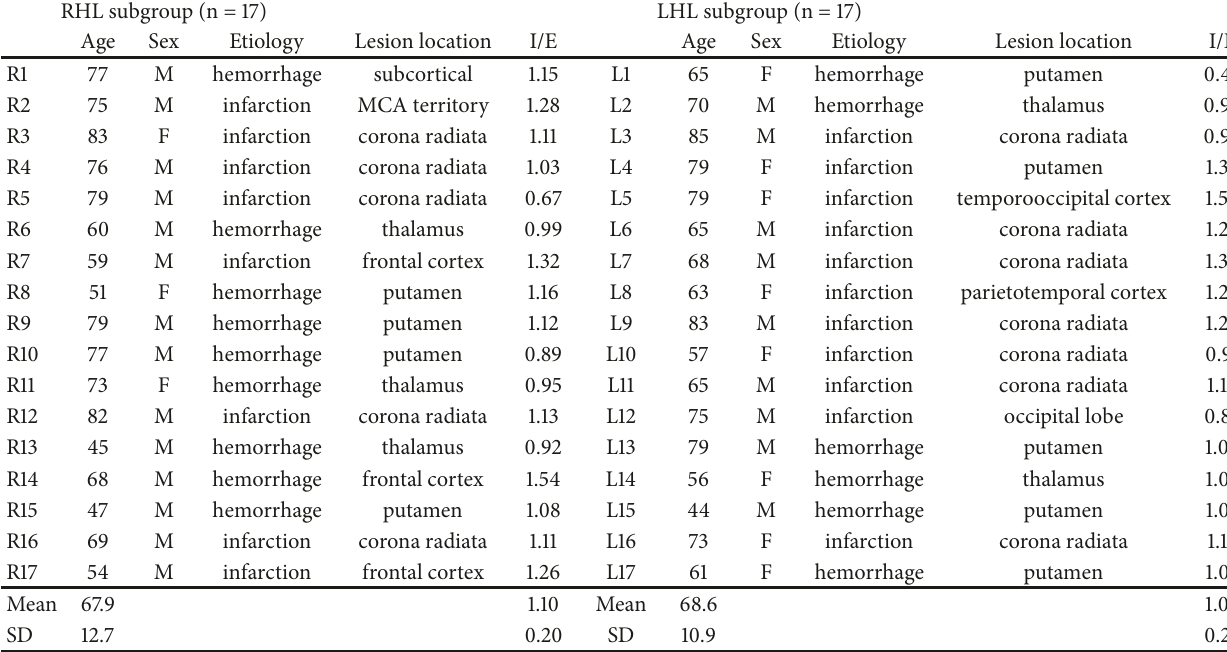
Table 1: Participant